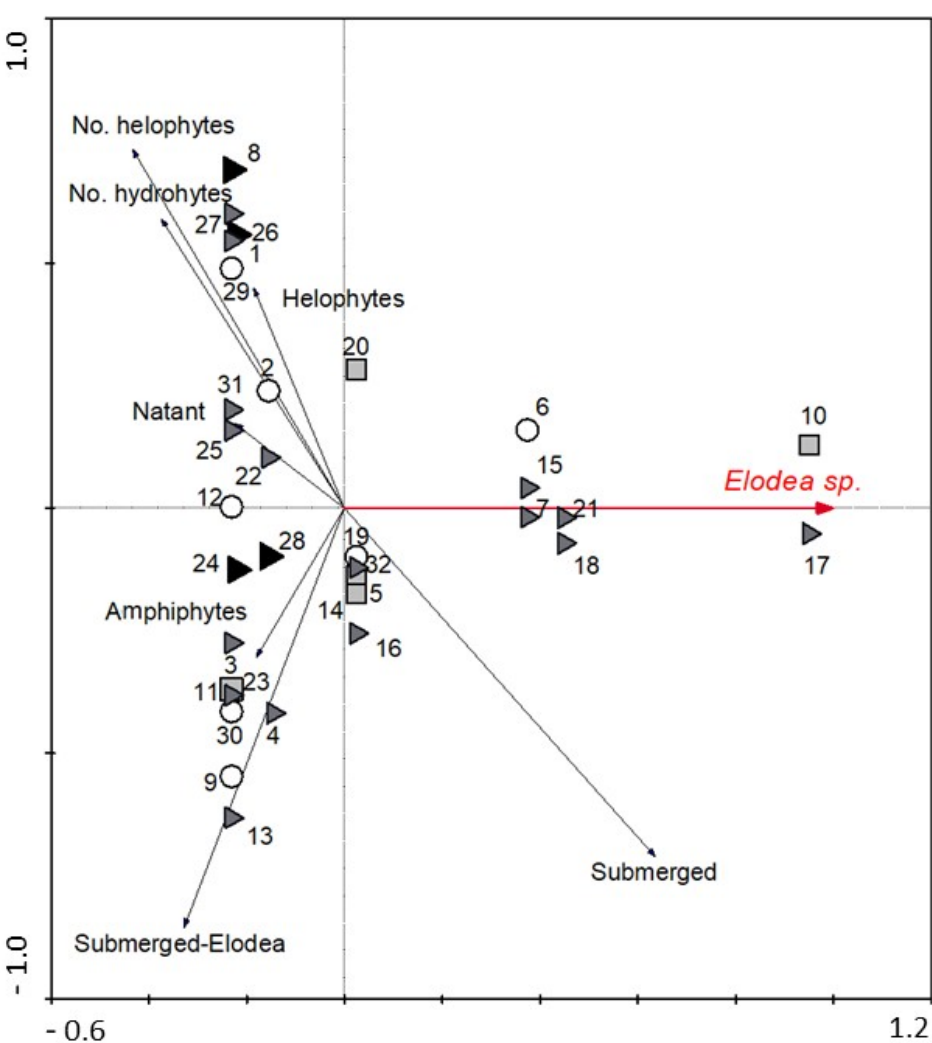
Figure 6. Detrended correspondence analysis ordination diagram showing the similarity of the macrophyte stands in different sites. Numbers from 1 to 32 indicate the location of the site with respect to the river Drava flow direction. Different symbols indicate different water bodies (white circles—ponds, light grey squares—oxbows, small dark grey right triangles—side channels, black right triangle—sample sites in the main channel of the river Drava.